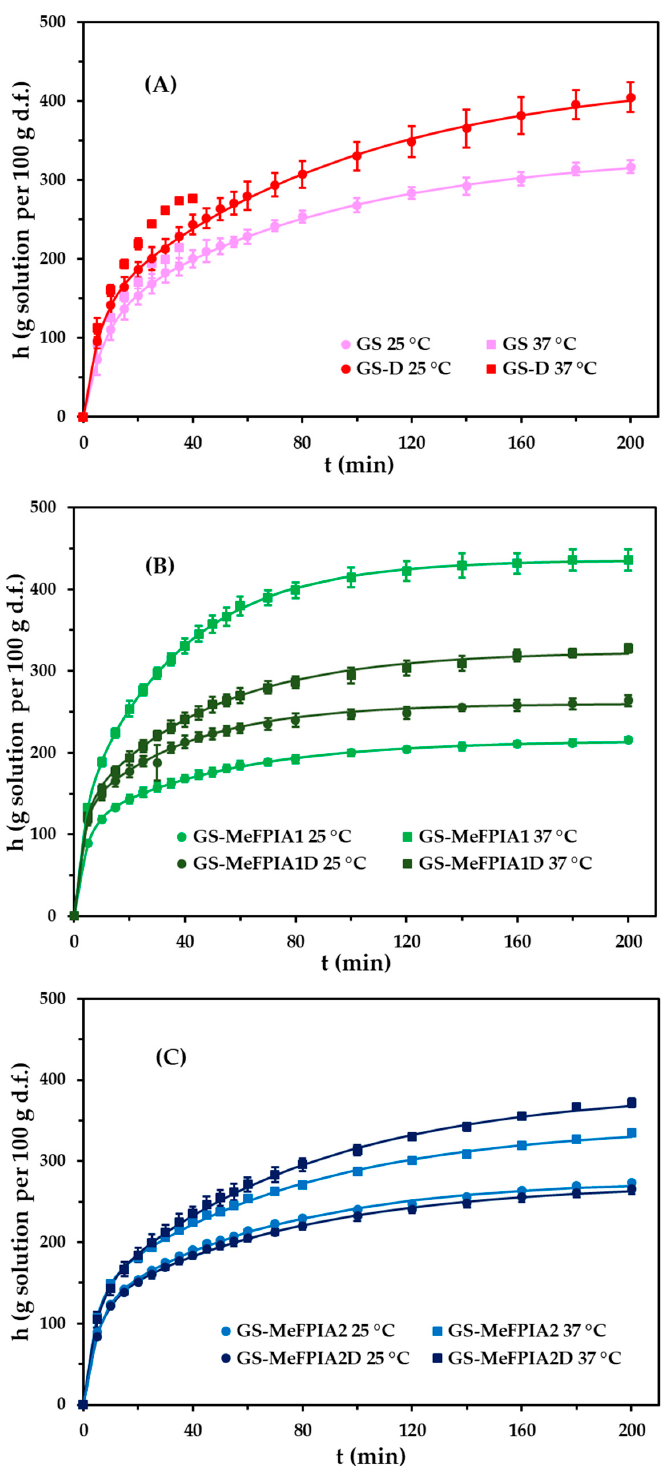
Figure 4. Swelling curves of the different films at 25 °C and 37 °C in phosphate buffer solution (PBS) buffer solutions: ( A ) GS and GS-D, ( B ) GS-MeFPIA1 and GS-MeFPIA1D, and ( C ) GS-MeFPIA2 and GS-MeFPIA2D.